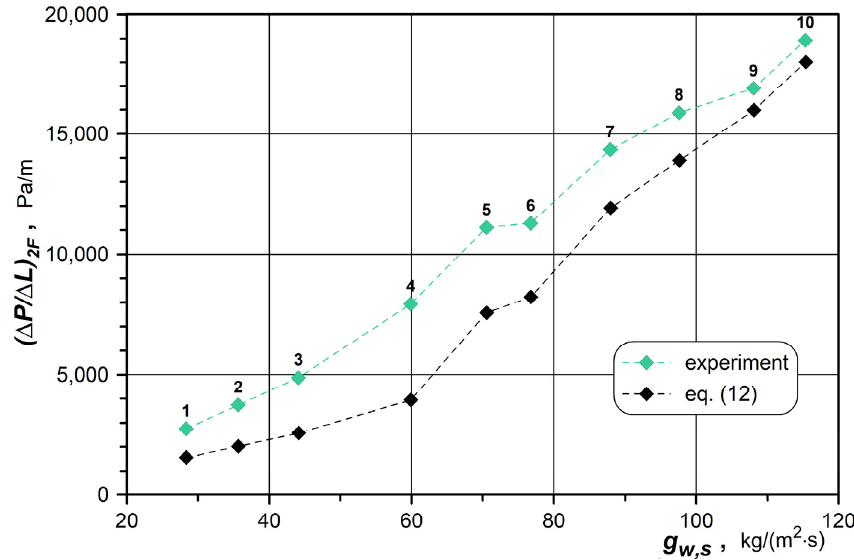
Figure 10. Measured and calculated specific flow resistance of two-phase air-water flow in a pipe with PPI40 aluminum foam packing.